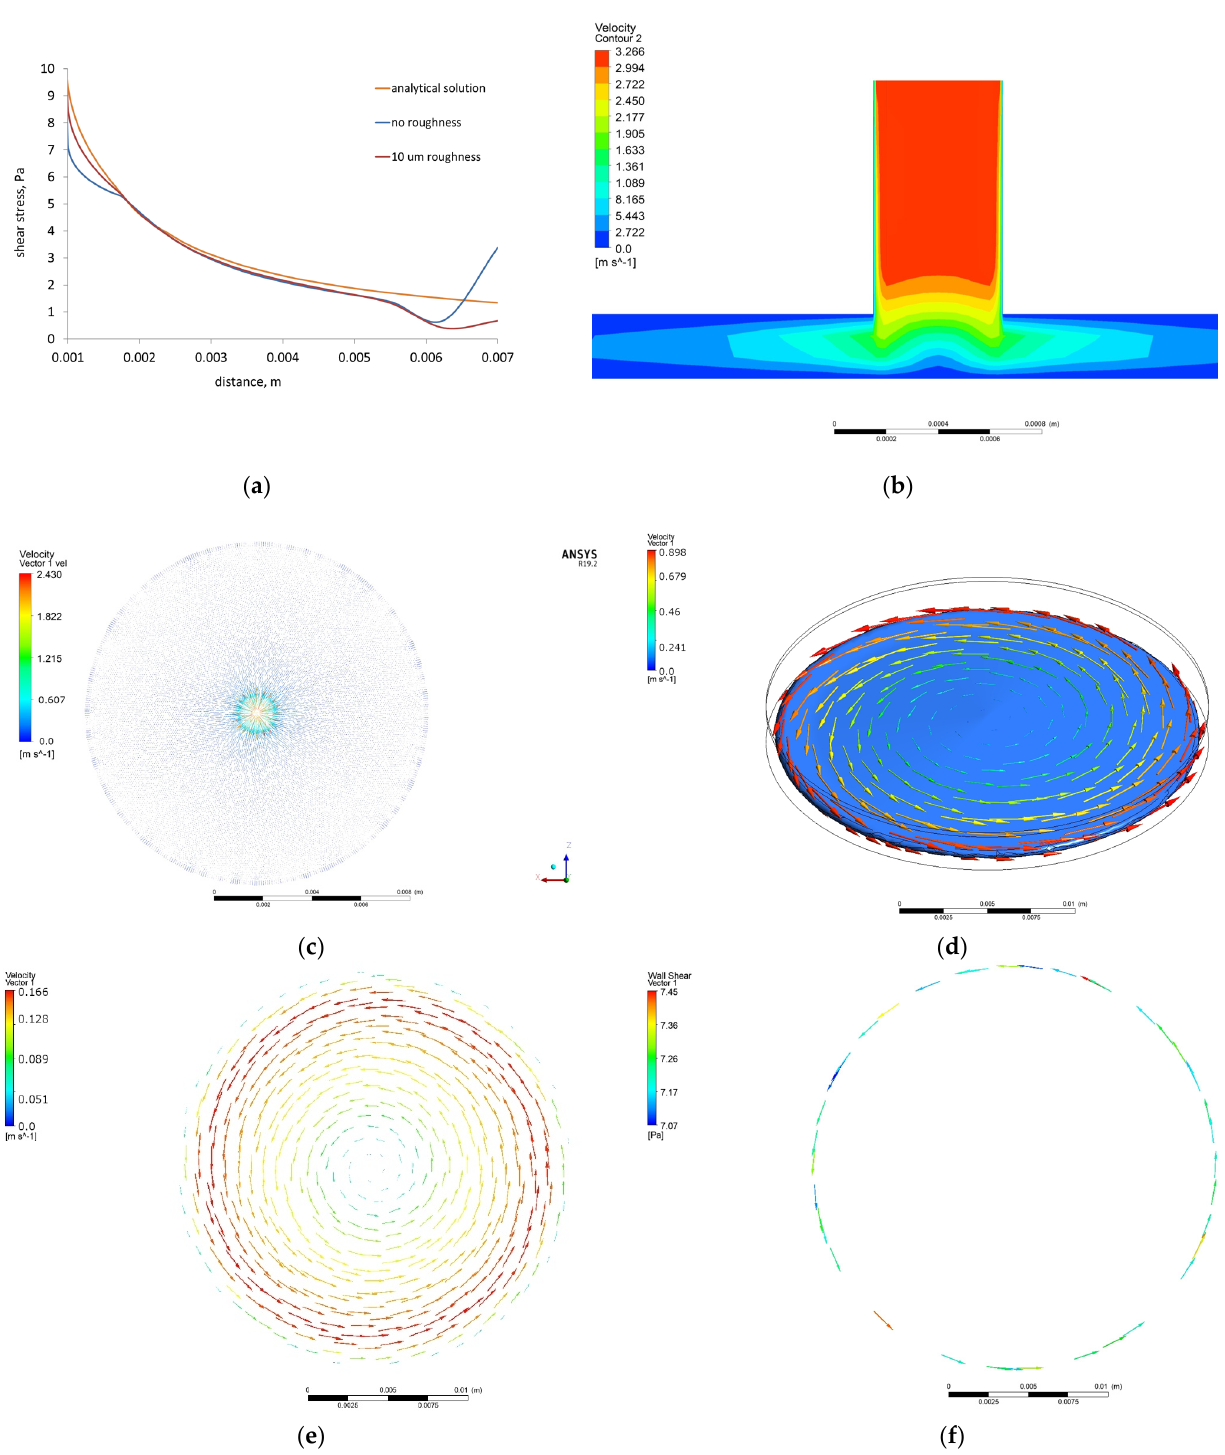
Figure 11. Results of 3D FVM radial flow test model: ( a ) Shear stress versus radius (distance from center of model) for models with roughness 10 µ m and without roughness, and for analytical solution; ( b ) Distribution of velocity on the XY cross-section plane of model with roughness 10 µ m; ( c ) Distribution of velocity on the XZ cross-section plane of model with roughness 10 µ m. Results of 3D FVM Impact-R test model with roughness 10 µ m: ( d ) Distributions of velocity vectors in whole model-bottom of cone, ( e ) Distributions of velocity vectors under rotating cone, ( f ) Distributions of shear stress vectors under rotating cone.